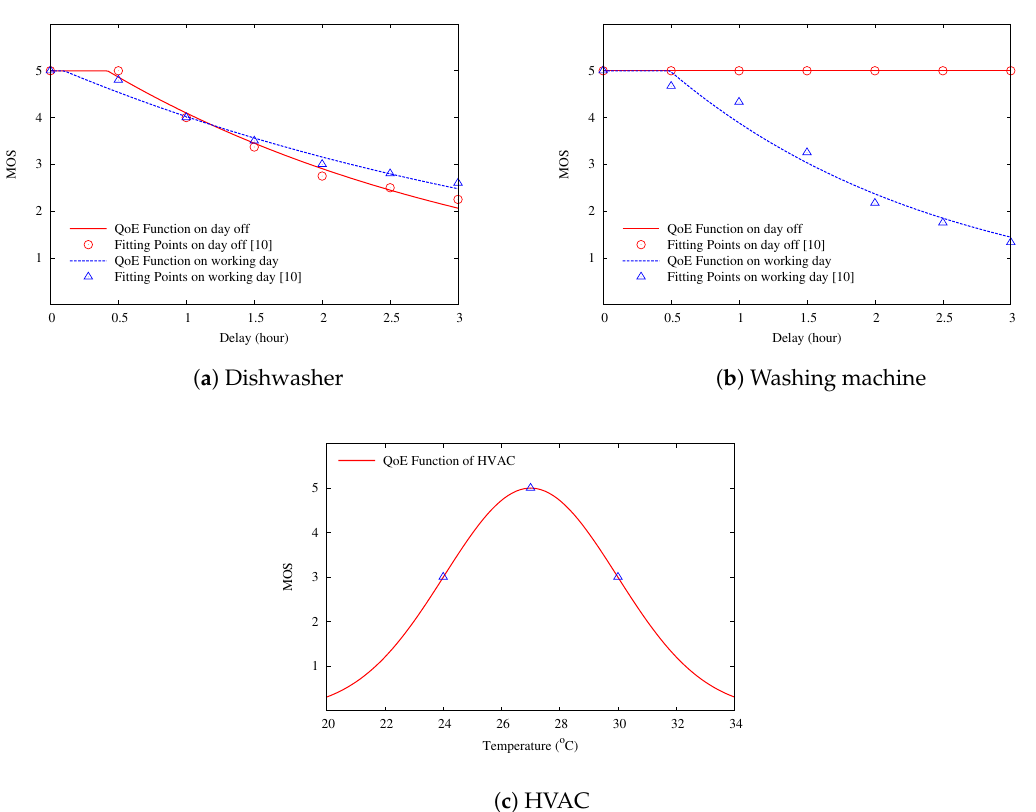
Figure 2. QoE mapping functions of dishwasher, washing machine, and